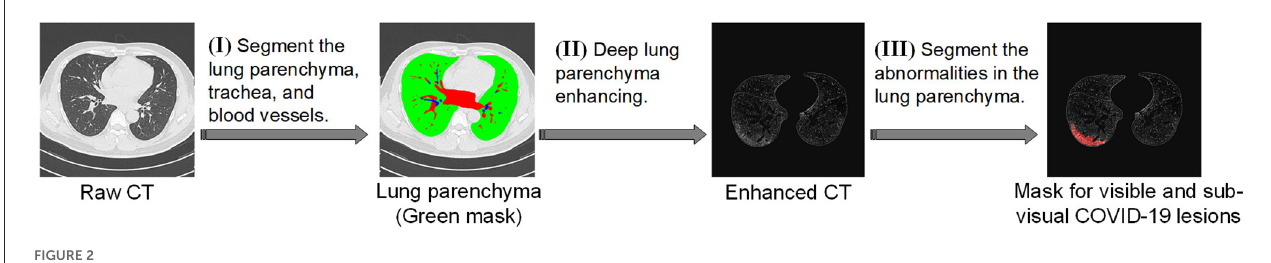
FIGURE2 Workflow of deep lung parenchyma enhancing.